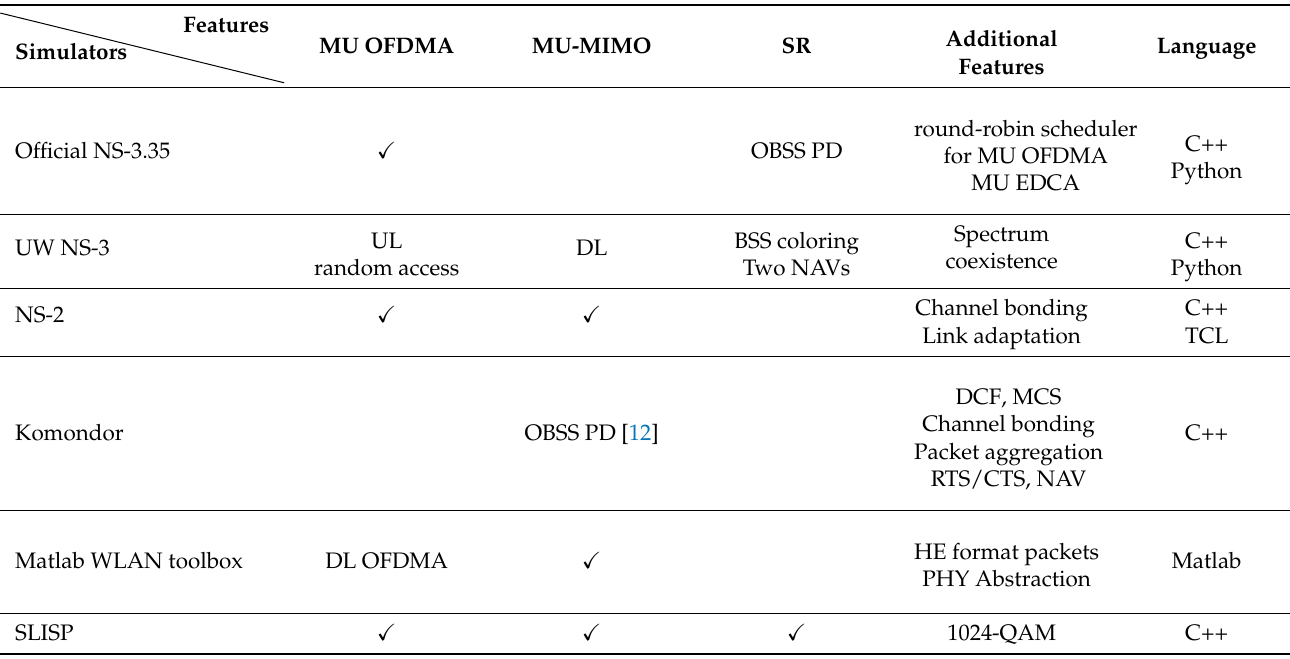
Table 8. Simulation tools’ supporting